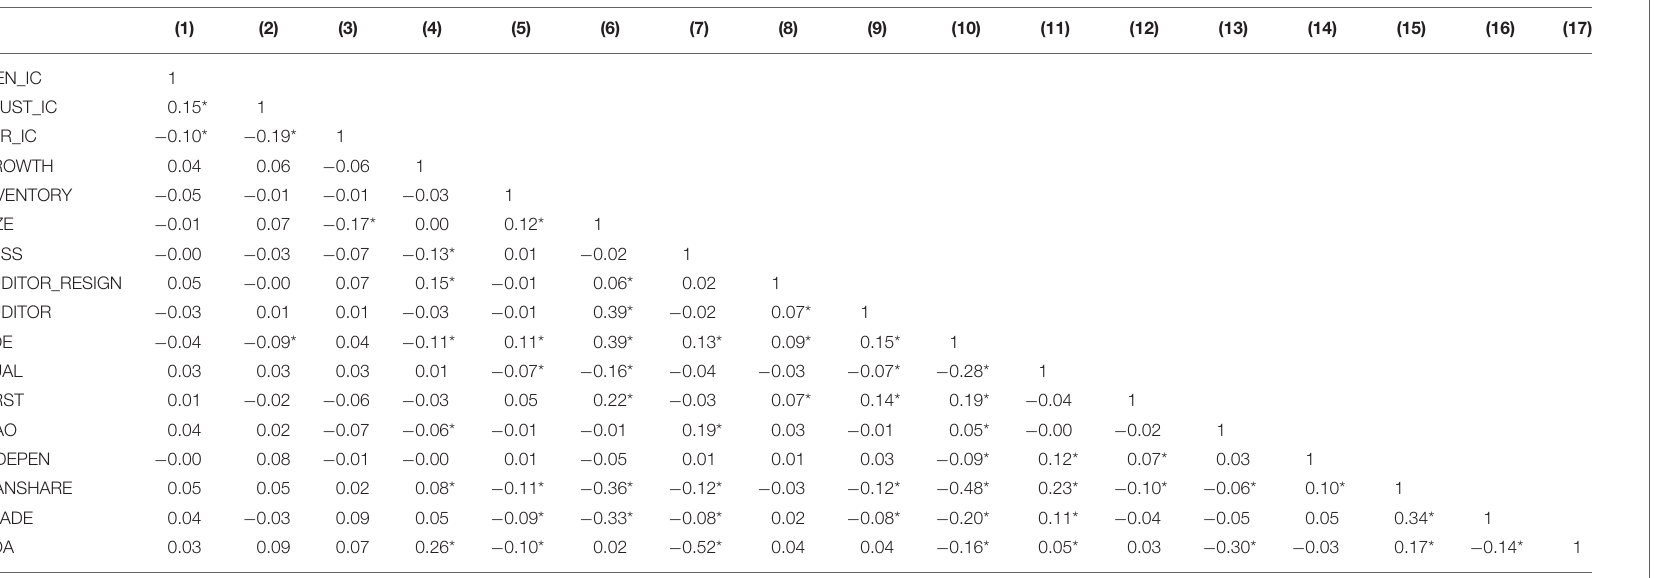
TABLE 5 | Correlation analysis: internal control